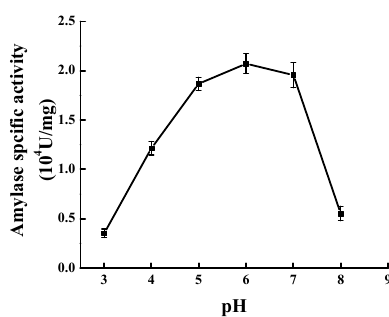
Figure 4. Effect of modification pH values on modification.